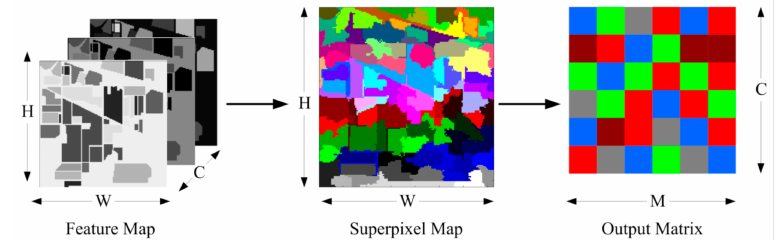
Figure 3. The structure of superpixel pooling